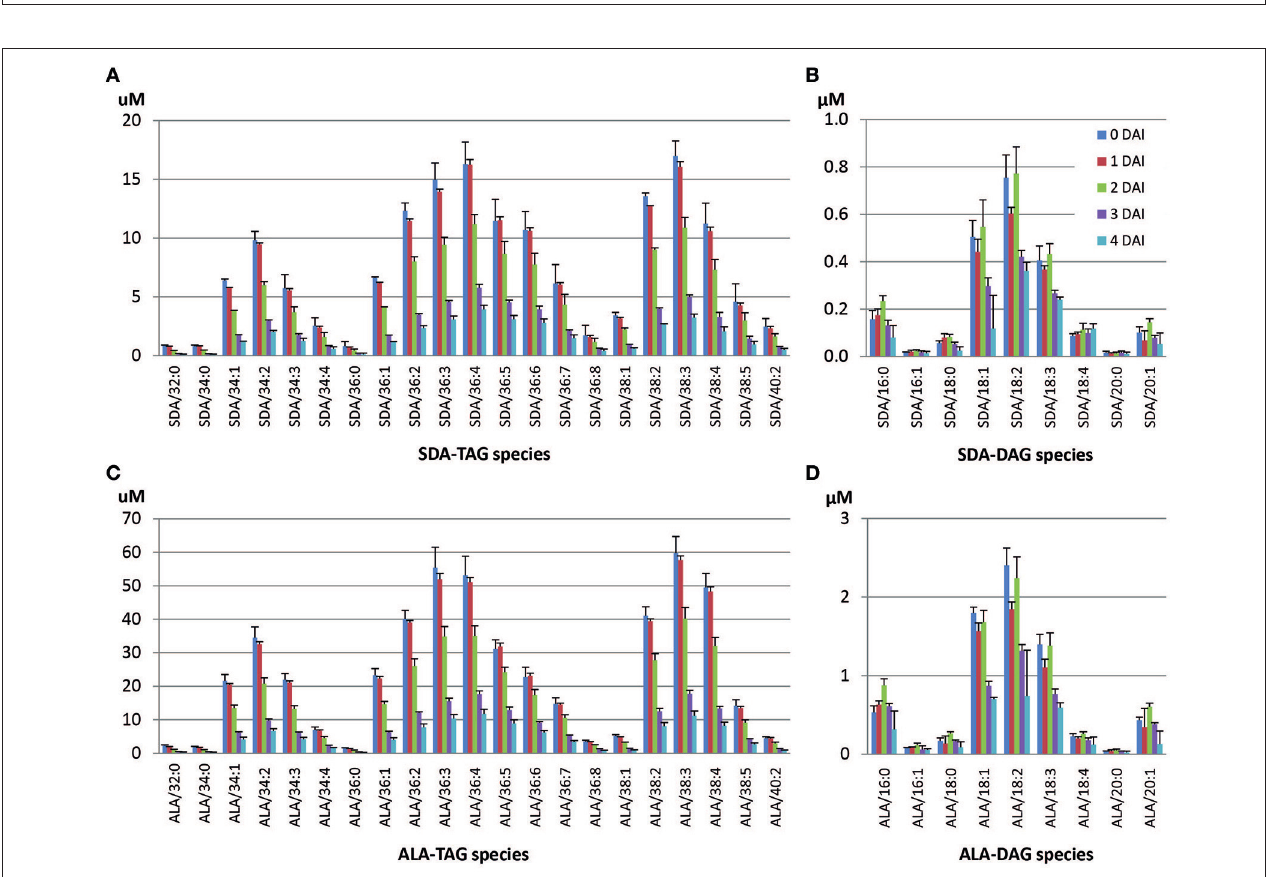
FIGURE 5 | Mobilization of SDA- or ALA-containing TAG and accumulated DAG species during seedling development in the SDA-line. (A) SDA-containing TAG species, (B) SDA-containing DAG species, (C) ALA-containing TAG species, (D) ALA-containing DAG species. The two numbers in species denotes total number of carbons and total number of double bonds of two or single fatty acids in the TAG or DAG species, respectively.